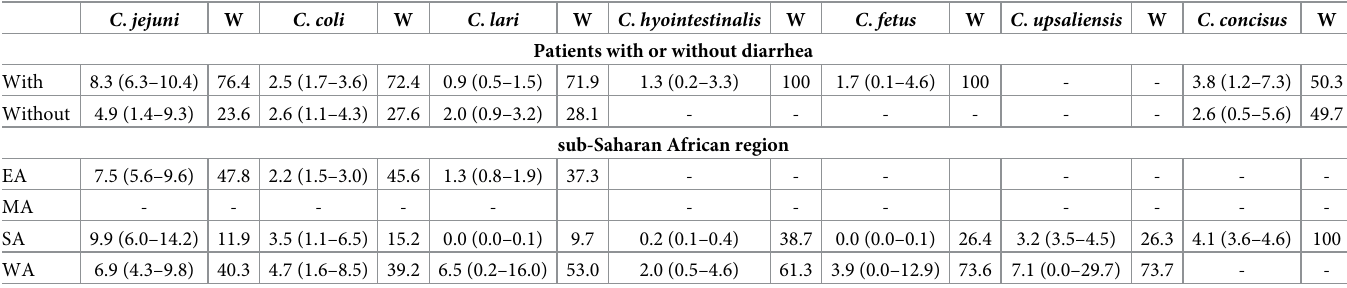
consistent with the sample size because Eastern Africa presented the largest sample size and weight (n = 32,256, weight = 55.0%). Middle Africa, with the lowest weight in the meta-analy- sis (1.7%) is the second region with the less countries in sub-Saharan Africa (9/53 countries).